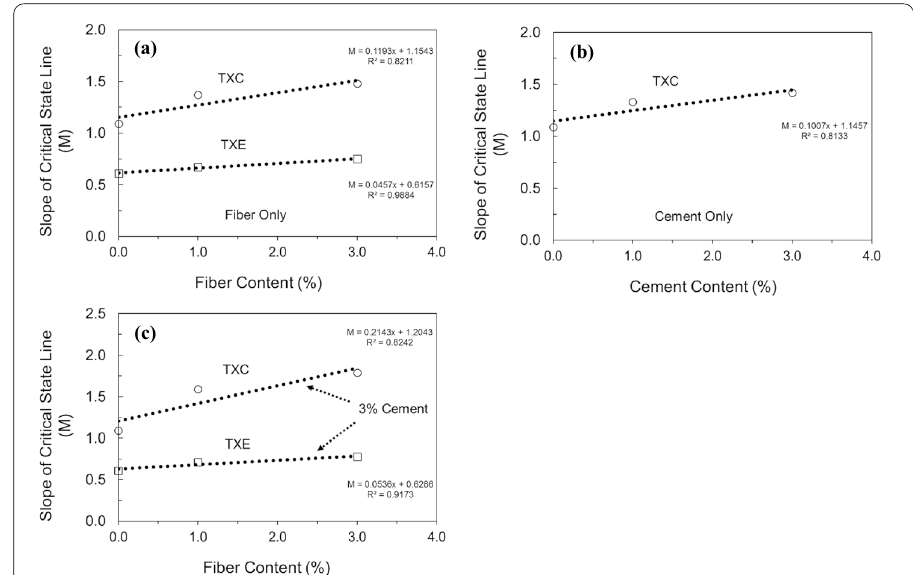
Fig. 11 Slope of the critical state line from CID tests for unreinforced, fibre, and fibre reinforced cemented Toyoura sand specimens a Slope of critical state line versus fibre content b Slope of critical state line versus cement content c Slope of critical state line versus fibre with 3% cement